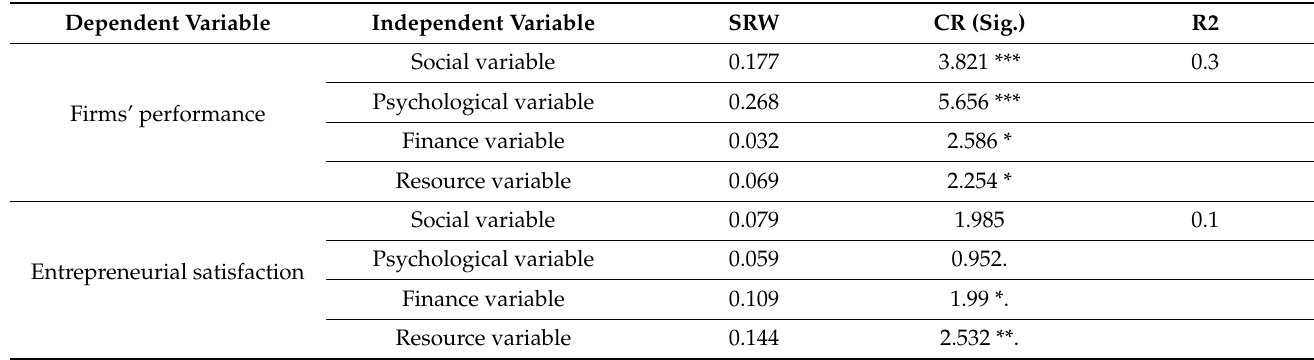
Table 6. Structural business modeling and composite